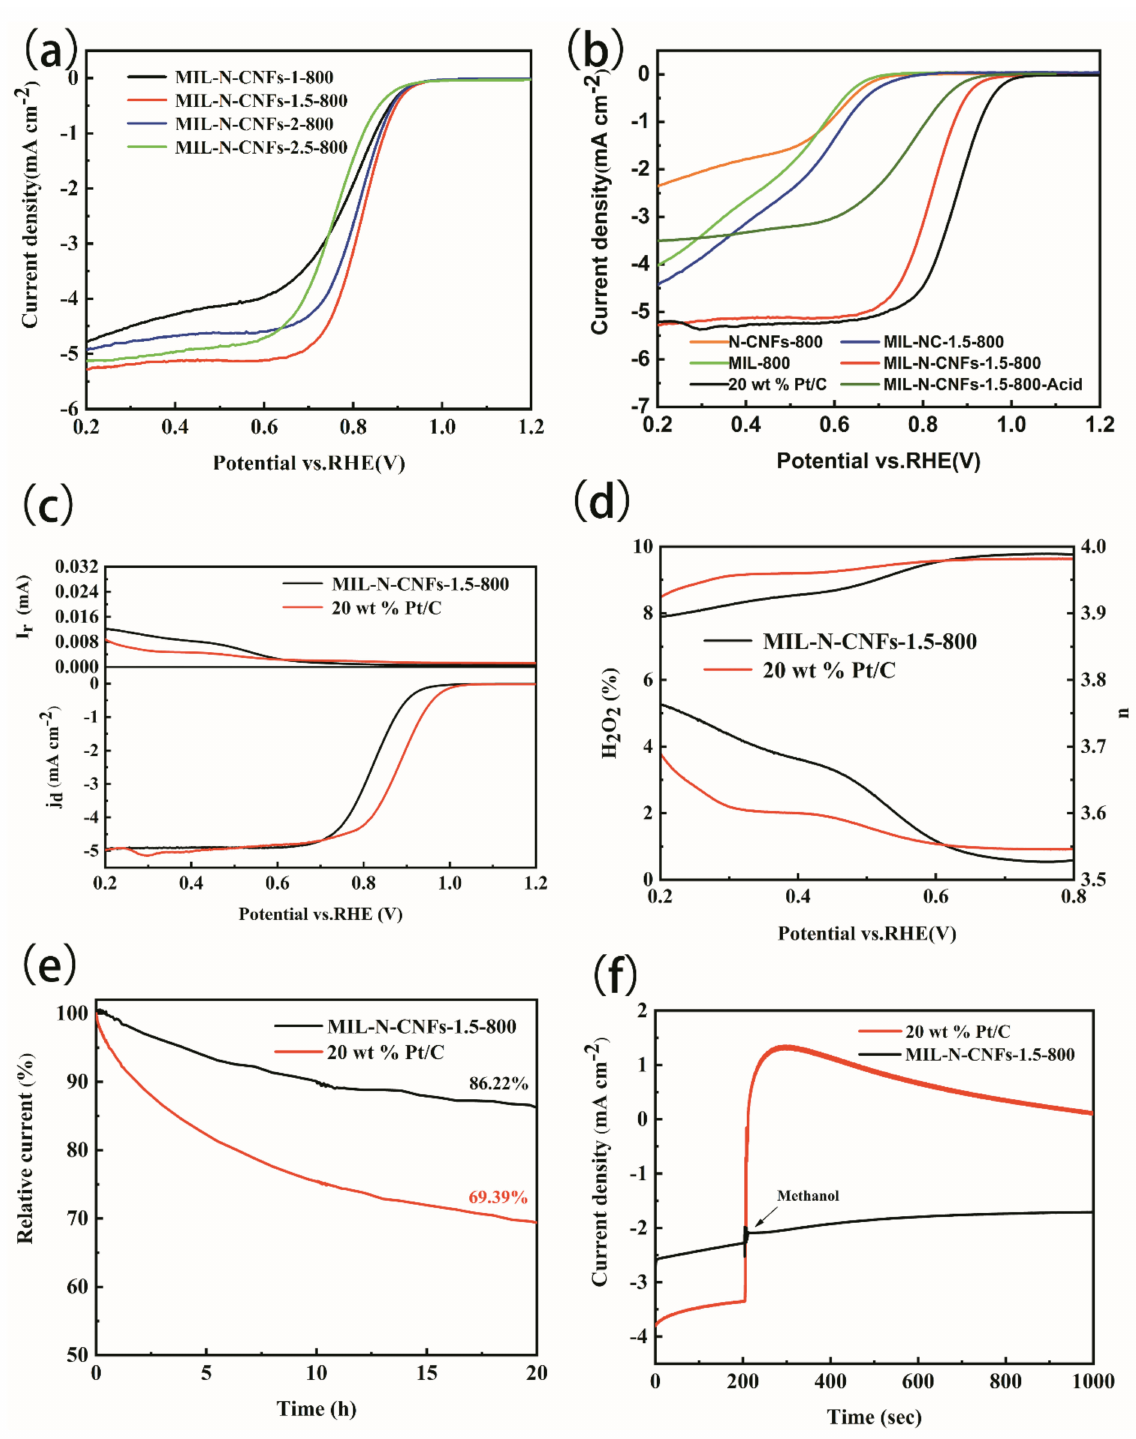
Figure 4. ORR polarization curves in 0.1 M KOH (rotating speed: 1600 rpms, scan rate: 10 mV s − 1 ) of the ( a ) MIL-N-CNFs-x-800 catalysts and ( b ) MIL-N-CNFs-1.5-800, MIL-800, MIL-NC-1.5-800, N- CNFs-800, MIL-N-CNFs-1.5-800-Acid and 20 wt.% Pt/C catalysts. ( c ) RRDE polarization curves in 0.1 M KOH (scan speed: 10 mV s − 1 , rotating speed: 1600 rpm) of MIL-N-CNFs-1.5-800 and 20 wt.% Pt/C. ( d ) Corresponding %H 2 O 2 and transferred electron number of MIL-N-CNFs-1.5-800 and 20 wt.% Pt/C during the ORR process. ( e ) Chronoamperometric responses of MIL-N-CNFs- 1.5-800 and 20 wt.% Pt/C at 0.6 V vs. RHE in O 2 -saturated 0.1 M KOH. ( f ) Chronoamperometric responses of MIL-N-CNFs-1.5-800 and 20 wt.% Pt/C after adding 5 vol % methanol at 200 s in O 2 -saturated 0.1 M